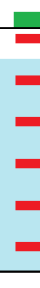
Figure 28. Several probes (in red) inside a container filled with water (in blue) are connected to a bus (in orange) and the acquisition module (in green).